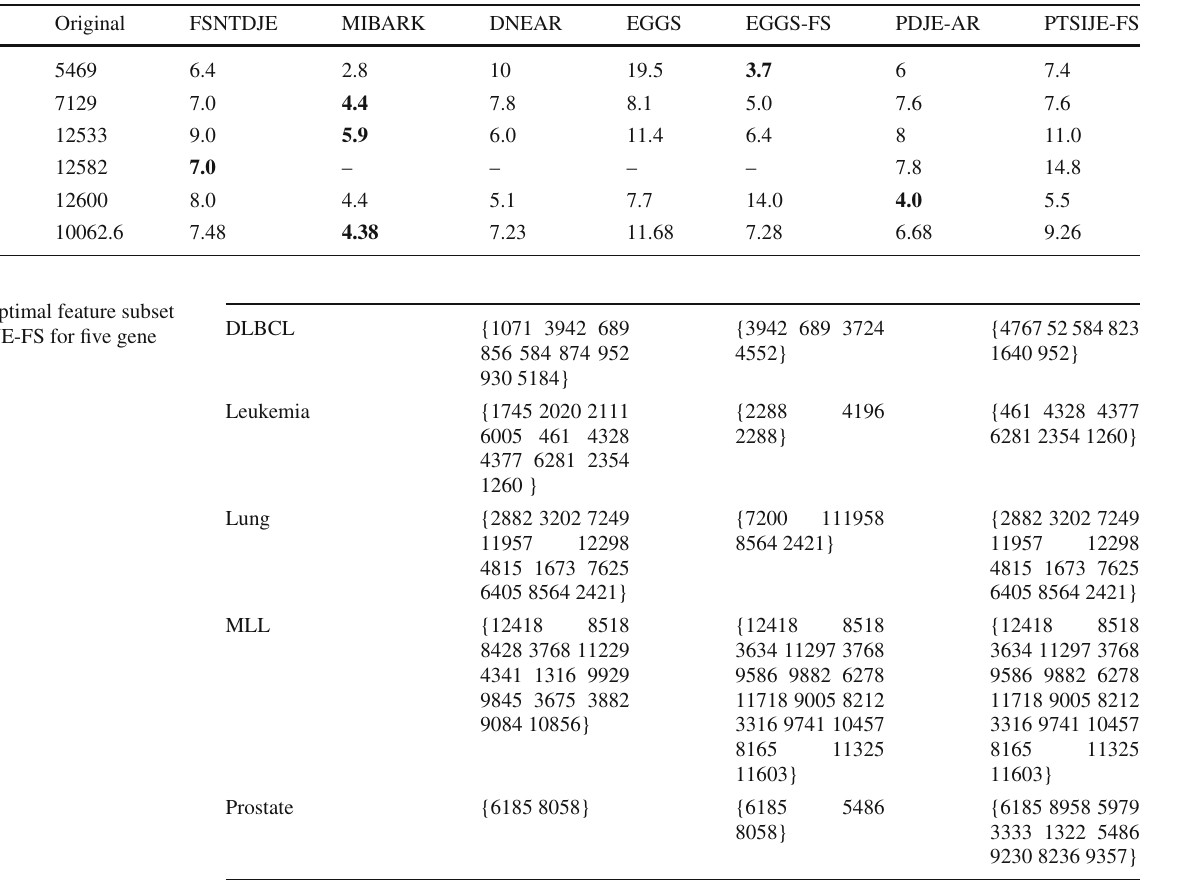
Table 7 Optimal gene subset with PSINTE-FS for five gene datasets Datasets